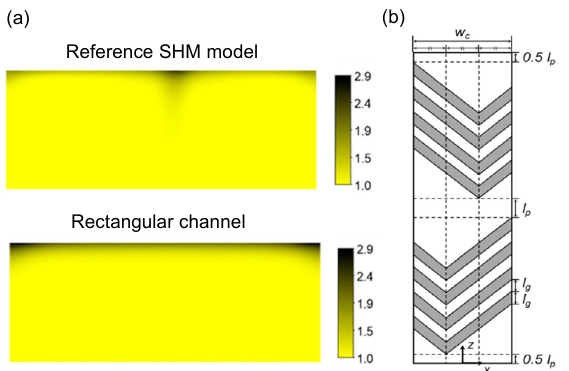
Figure 5. ( a ) Evolution of the concentration distribution in a staggered herringbone mixer (SHM) and in a plain rectangular channel with a permeating wall on top. Color contours represent the dimensionless concentration; ( b ) periodic unit of a staggered herringbone mixer. Adapted from [93].